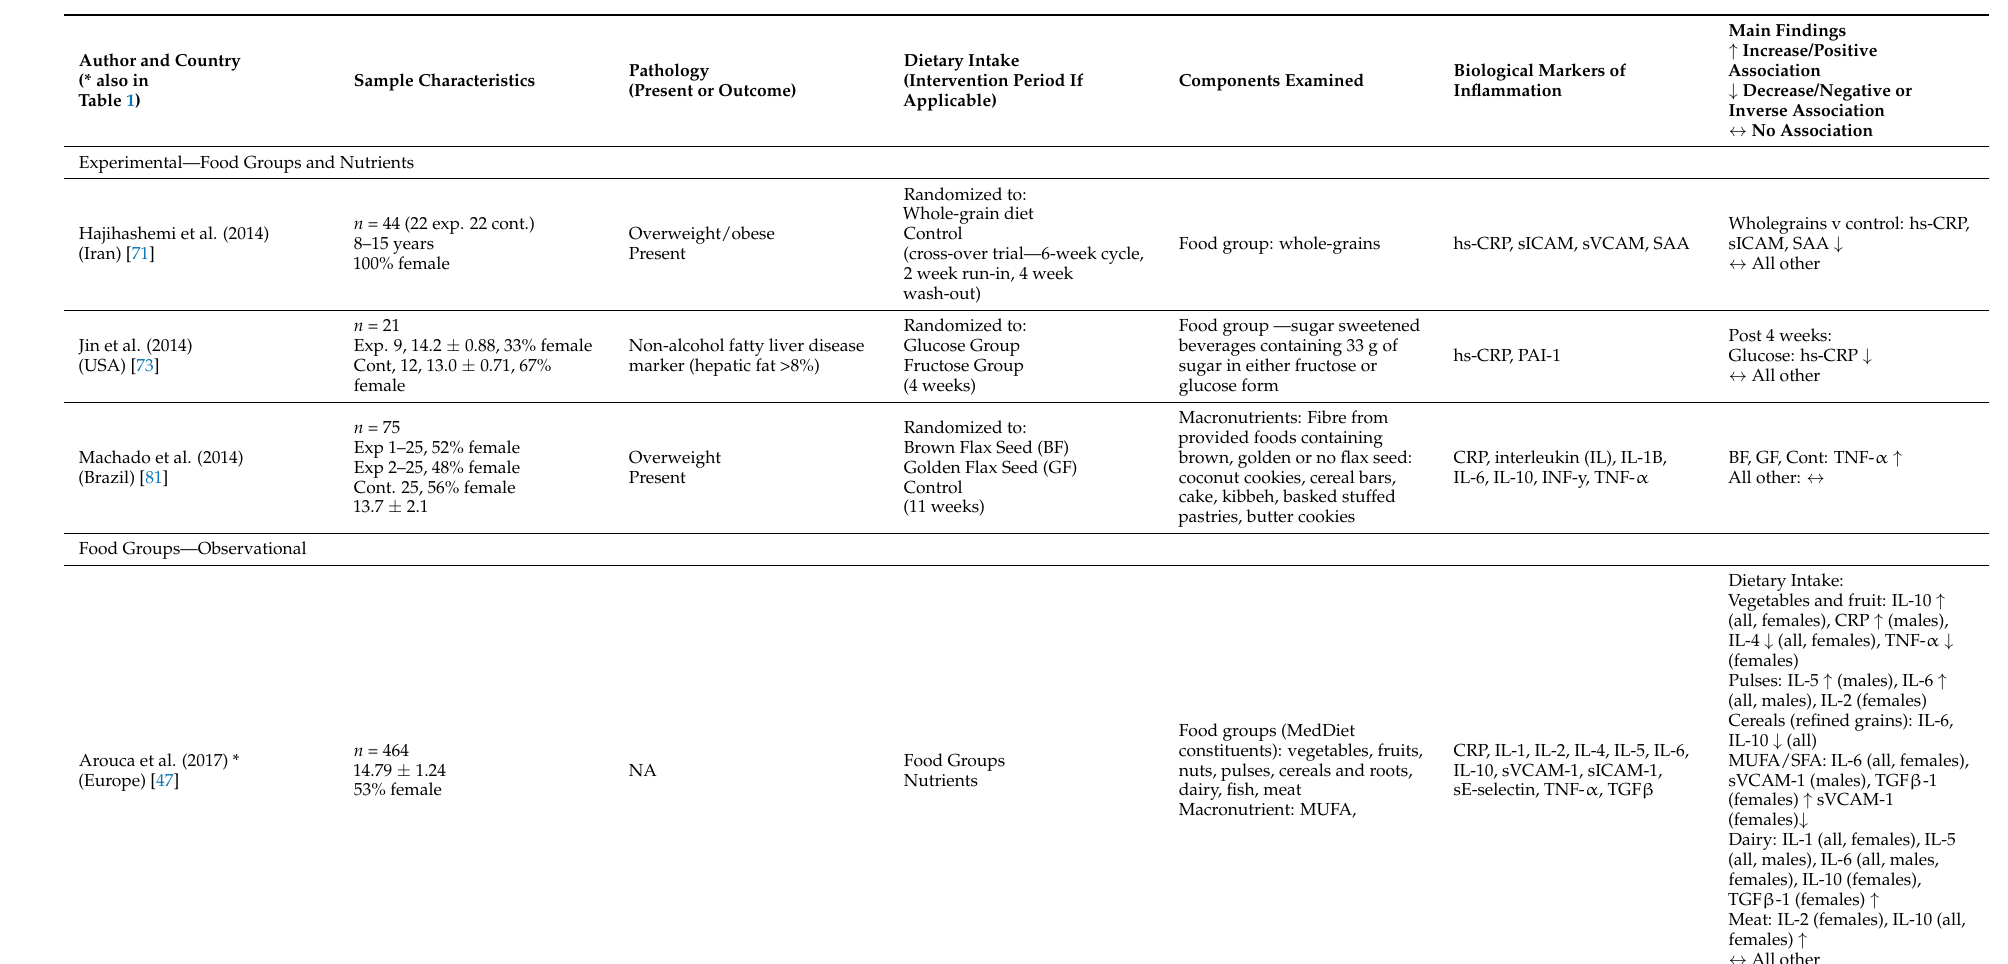
Table 2. Summary of studies investigating the associations between food groups and/or nutrients and biological markers of inflammation in children and adolescents.